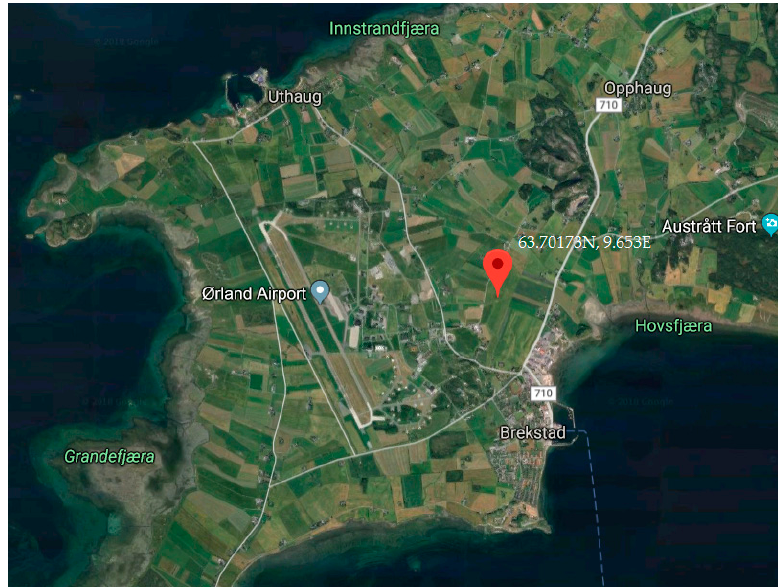
Figure 1. The area around the wind farm (Source: Google Earth).